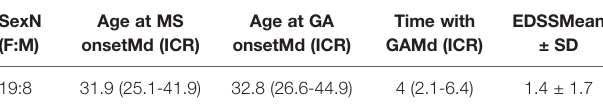
TABLE 2 | Demographic and clinical